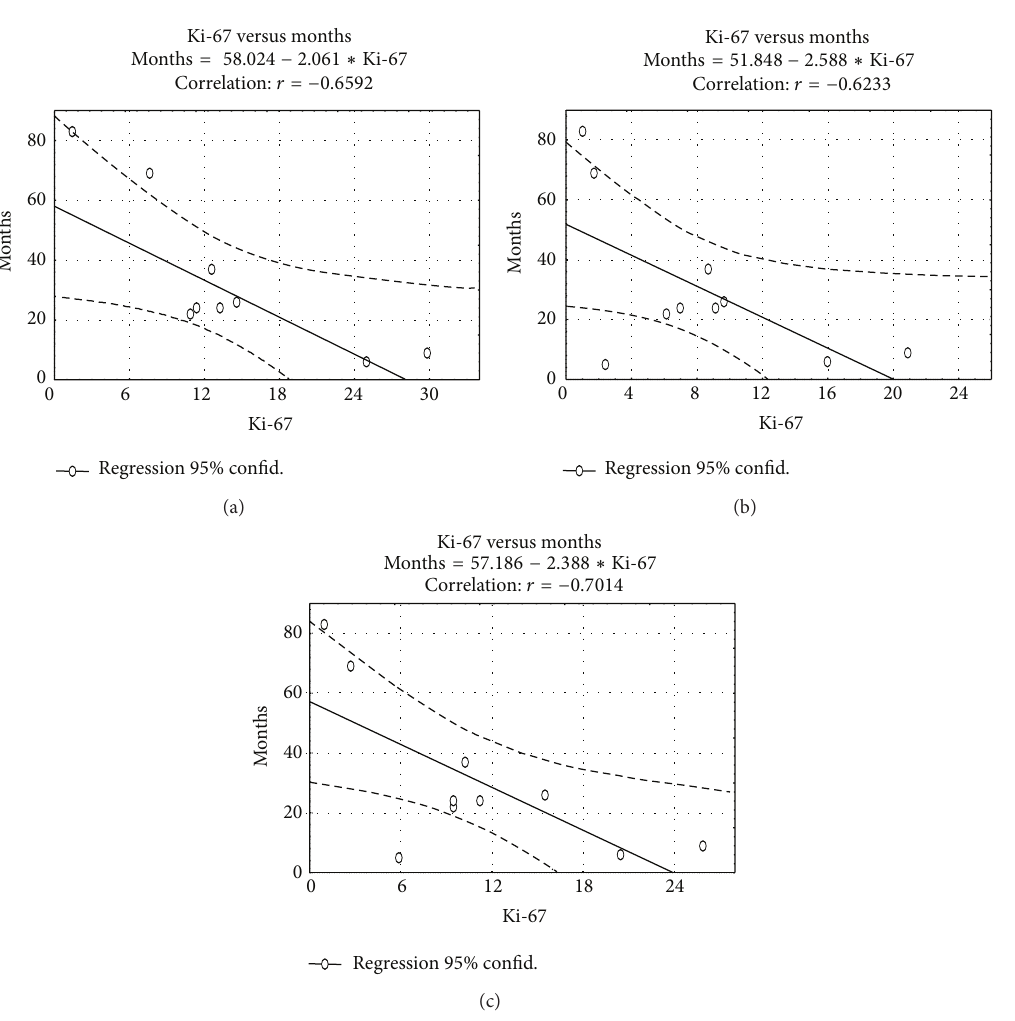
Figure 7: The regression function estimated for the number of months between recurrences of meningioma related to the value of Ki-67 index calculated based on (i) fully automatic method (a), (ii) traditional microscopic assessment (b), and (iii) semiautomatic human-computer hybrid approach